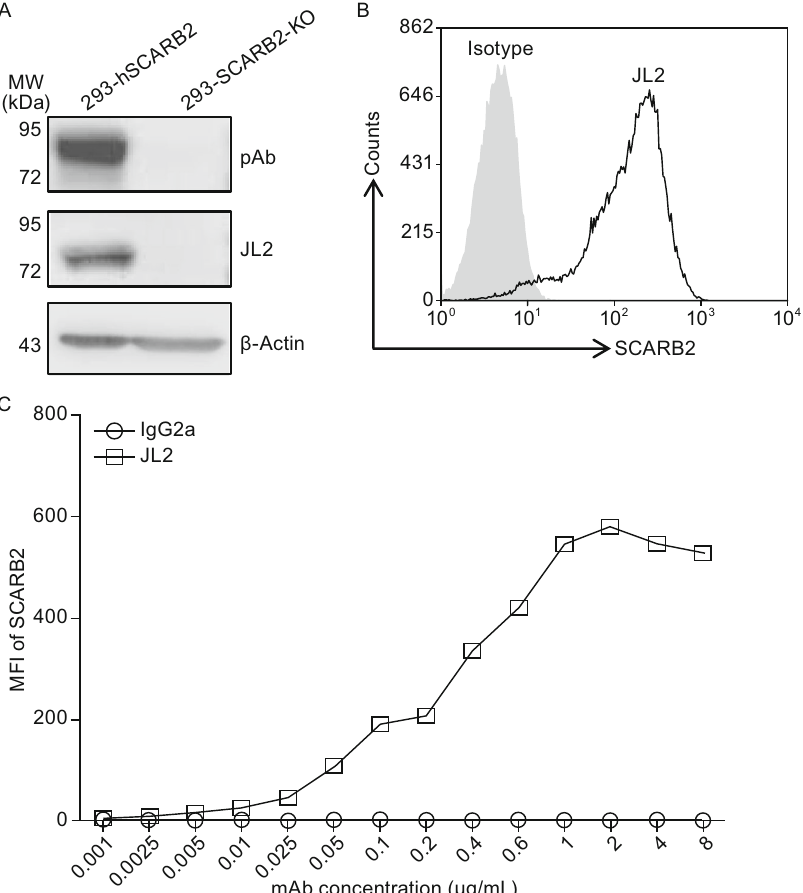
Figure 1. The monoclonal antibody JL2 binds human SCARB2. (A) Cells overexpressing human SCARB2 and SCARB2 knockout cells were lysed and analyzed by Western blot using the anti-human SCARB2 polyclonal antibody (pAb) (top panel) and JL2 (middle panel). The lowest panel: β -actin was used as a loading control. (B) Surface staining of 293-hSCARB2 cells. Open area represents staining with JL2 and shaded area represents isotype control staining. (C) The binding of 293-hSCARB2 cells with different concentrations of JL2 (square) and the IgG2a isotype control